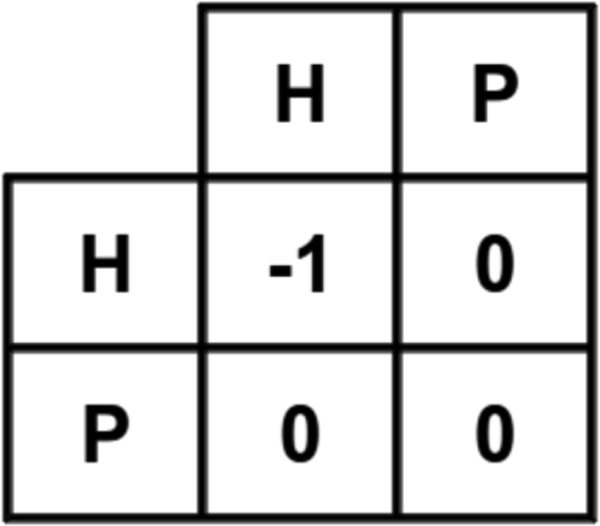
HP model. HP energy model [22].